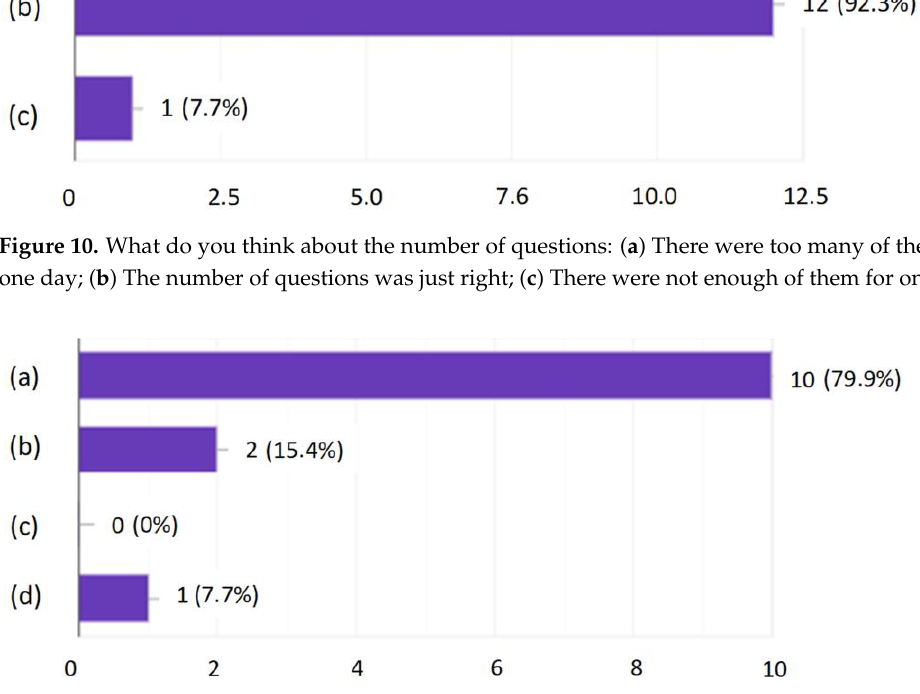
Figure 11. How do you assess the contact with the person responsible for the test: ( a ) Very good; ( b ) Good; ( c ) Difficult; ( d ) Contact was not necessary.